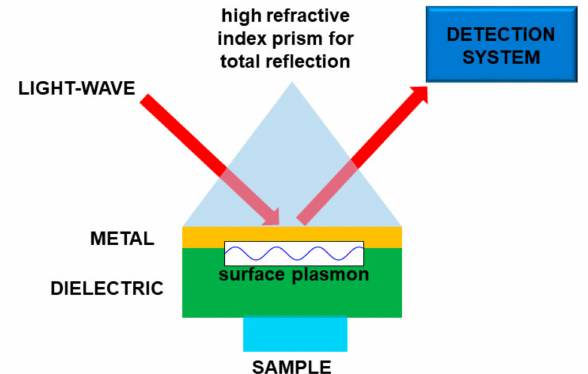
Figure 8. Sketch of a plasmonic sensor. In this particular case the light is used to “read” the sensor. Molecule “detection” is performed by means of the interaction between the sample and a material supporting the surface